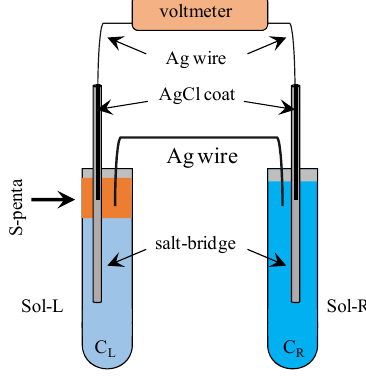
Figure 3. Experimental setup for measuring the potential across the membrane of a silver wire & S ‐ penta. C L and C R represent the concentration of left NaCl and right KCl solutions, respectively. The end of Ag wire which was connected to the voltmeter was coated with AgCl.